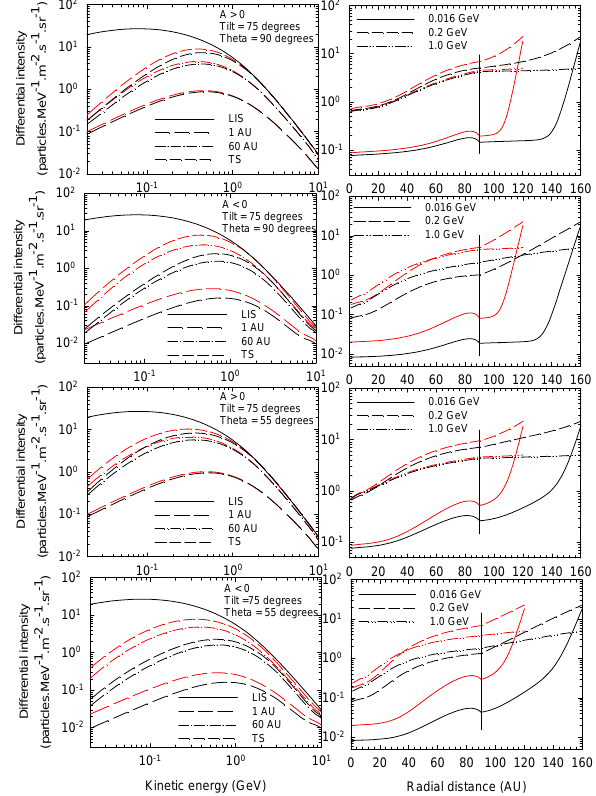
Fig. 1. Left panels: top two figures, computed differential intensi- ties for galactic protons with α =75 ◦ as a function of kinetic energy for both polarity cycles, at radial distances of 1 AU, 60 AU and the TS location (bottom to top) in the equatorial plane ( θ =90 ◦ ). Bot- tom two figures: similar but at θ =55 ◦ . Right panels: corresponding differential intensities as a function of radial distance for 0.016, 0.2 and 1.0GeV, respectively. The TS is at 90 AU, as indicated, with the heliopause at 120 AU (red curves) and 160 AU (black curves) respectively, where the LIS was